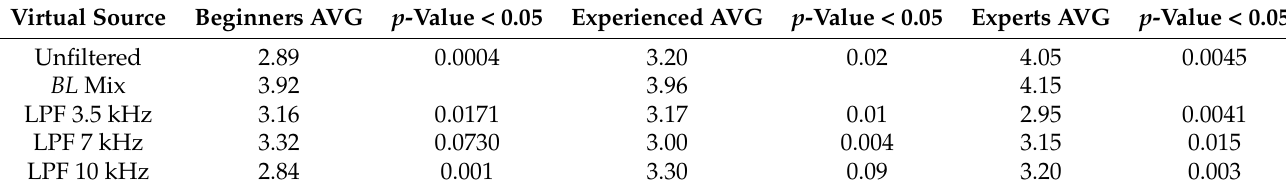
Table 8. T -test results—experience.